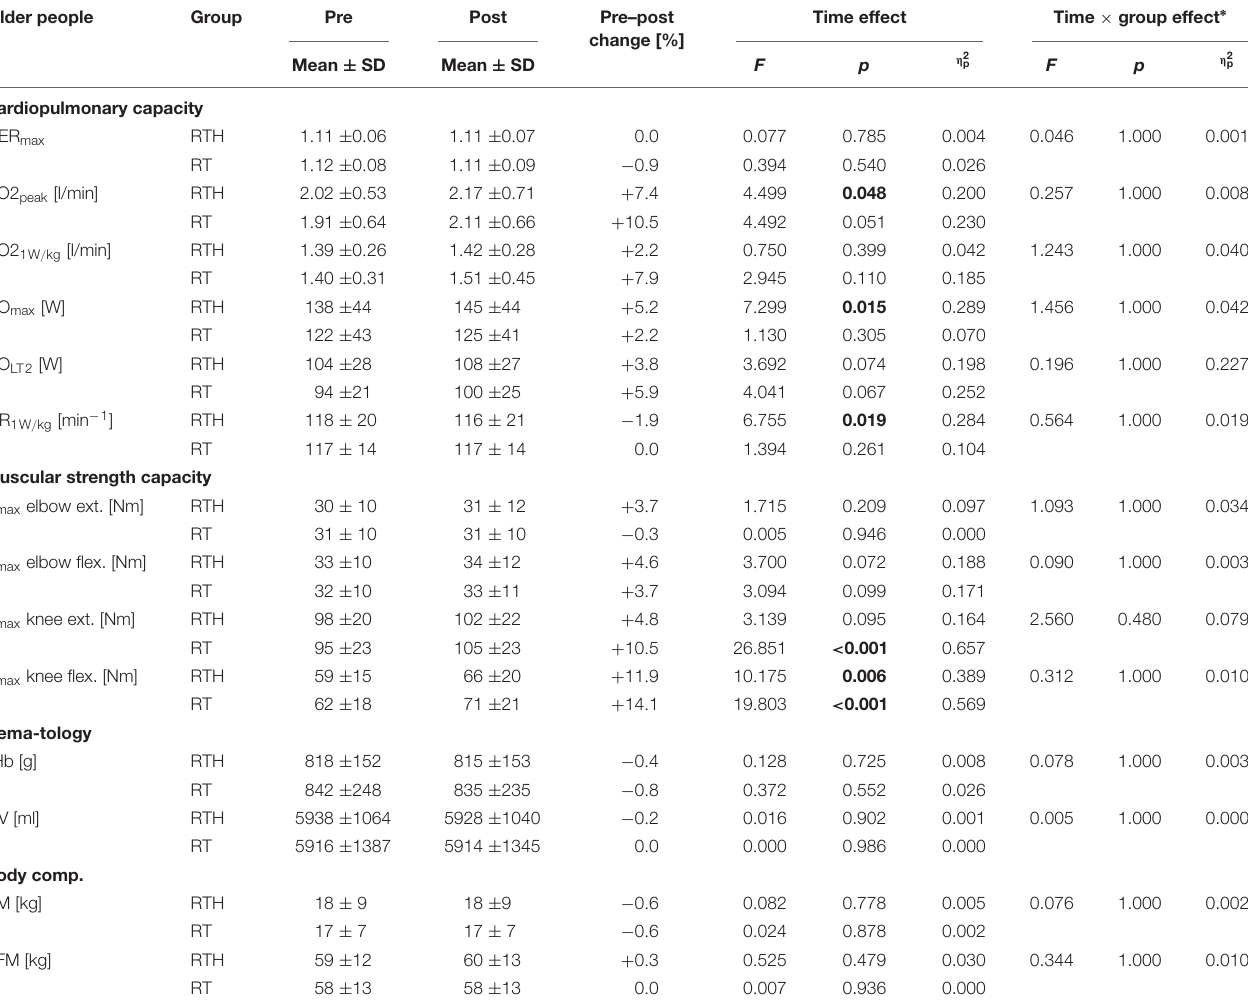
TABLE 3 | Pre–post results of the cardiopulmonary capacity, muscular strength capacity, hematological parameters, and body composition of the group RTH old (resistance training under hypoxia) and RT old (resistance training under normoxia). Older people Group Pre Post Pre–post